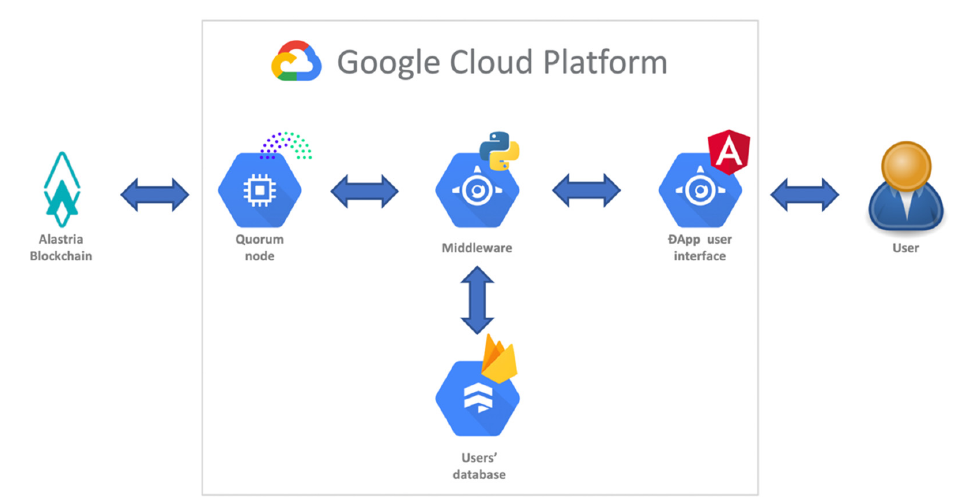
Figure 6. Clockchain ÐApp cloud architecture.